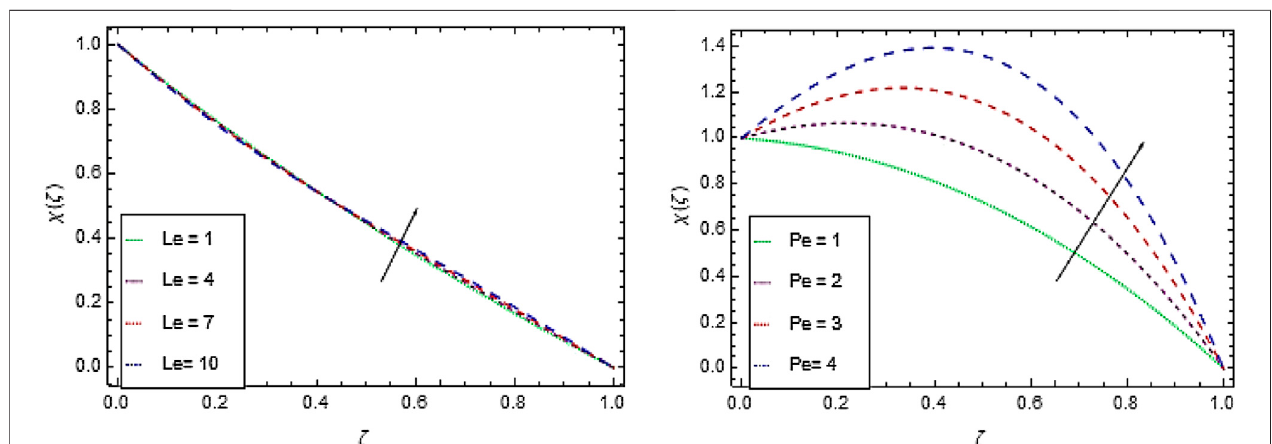
FIGURE 7 | χ ( ζ ) as a function of (A) Le and (B) Pe .